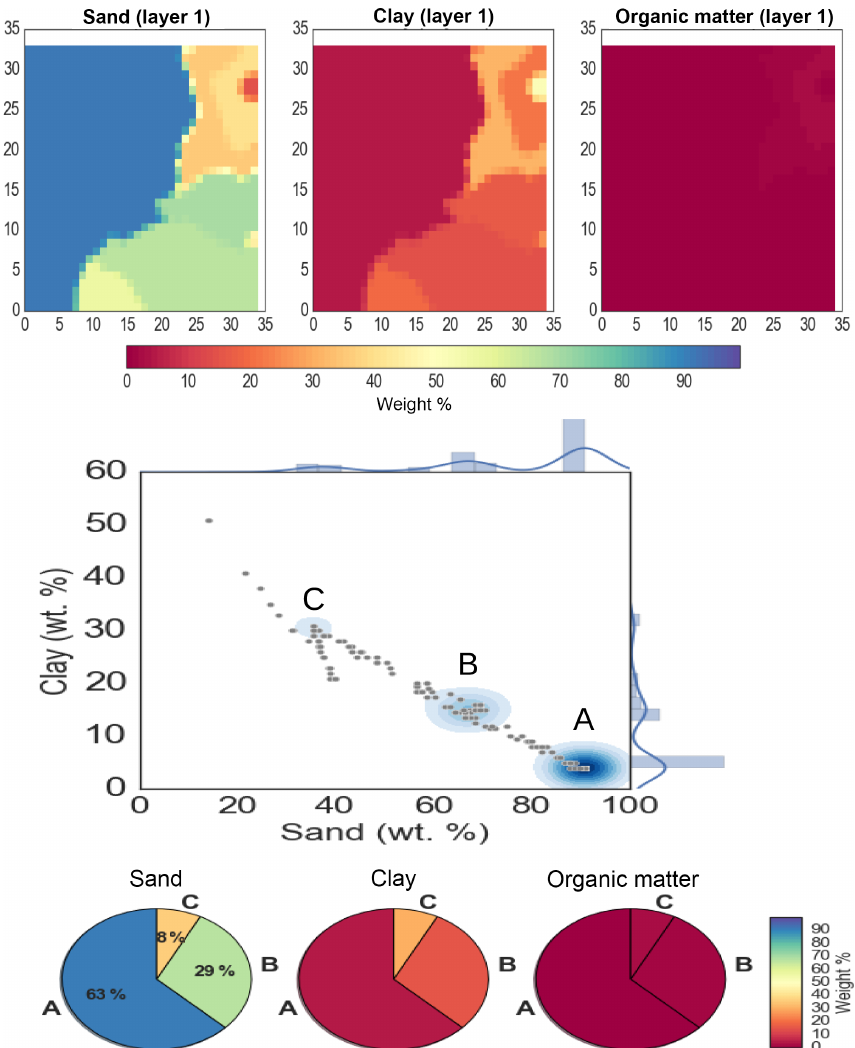
Figure 2. Example CLASS-CTEM grid cell located in the Sudan (12.6 ◦ N, 28.1 ◦ E). The top panel shows the GSDE sand, clay, and organic carbon weight percents for GSDE cells within the CLASS-CTEM grid cell. Each GSDE grid cell is 5arcmin by 5arcmin. The numbers on the plot axes are the number of GSDE grid cells along that axis. The joint distribution using kernel density estimation for the soil sand and clay content is shown in the centre panel. The histograms on the axes and the blue colour scaling demonstrate qualitatively the number of GSDE grid cells sharing the similar soil textural space. The clustering algorithm found three clusters (labelled A, B, and C) with a fractional area per cluster and soil texture as shown in the pie charts. The pie charts can be visually referenced to the top panel which uses the same colour scheme, e.g. cluster A covers 63% of the CLASS-CTEM grid cell with 91% sand, 4% clay, and 1% OM. In the scatter plot, the label is placed close to the cluster value to help illustrate the cluster relation in sand–clay